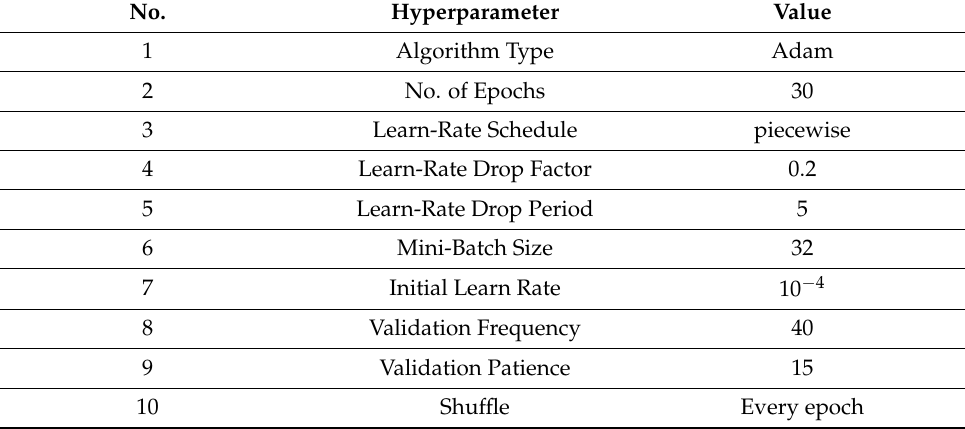
Table 2. Training